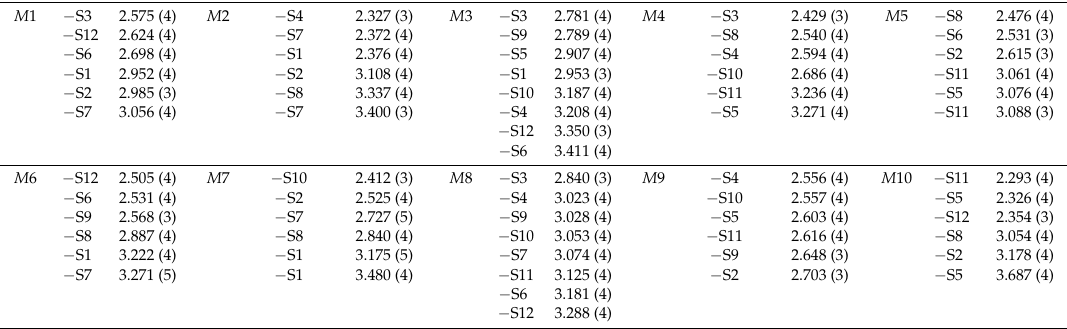
Table 4. Selected bond distances (in Å) in the crystal structure of oyonite.